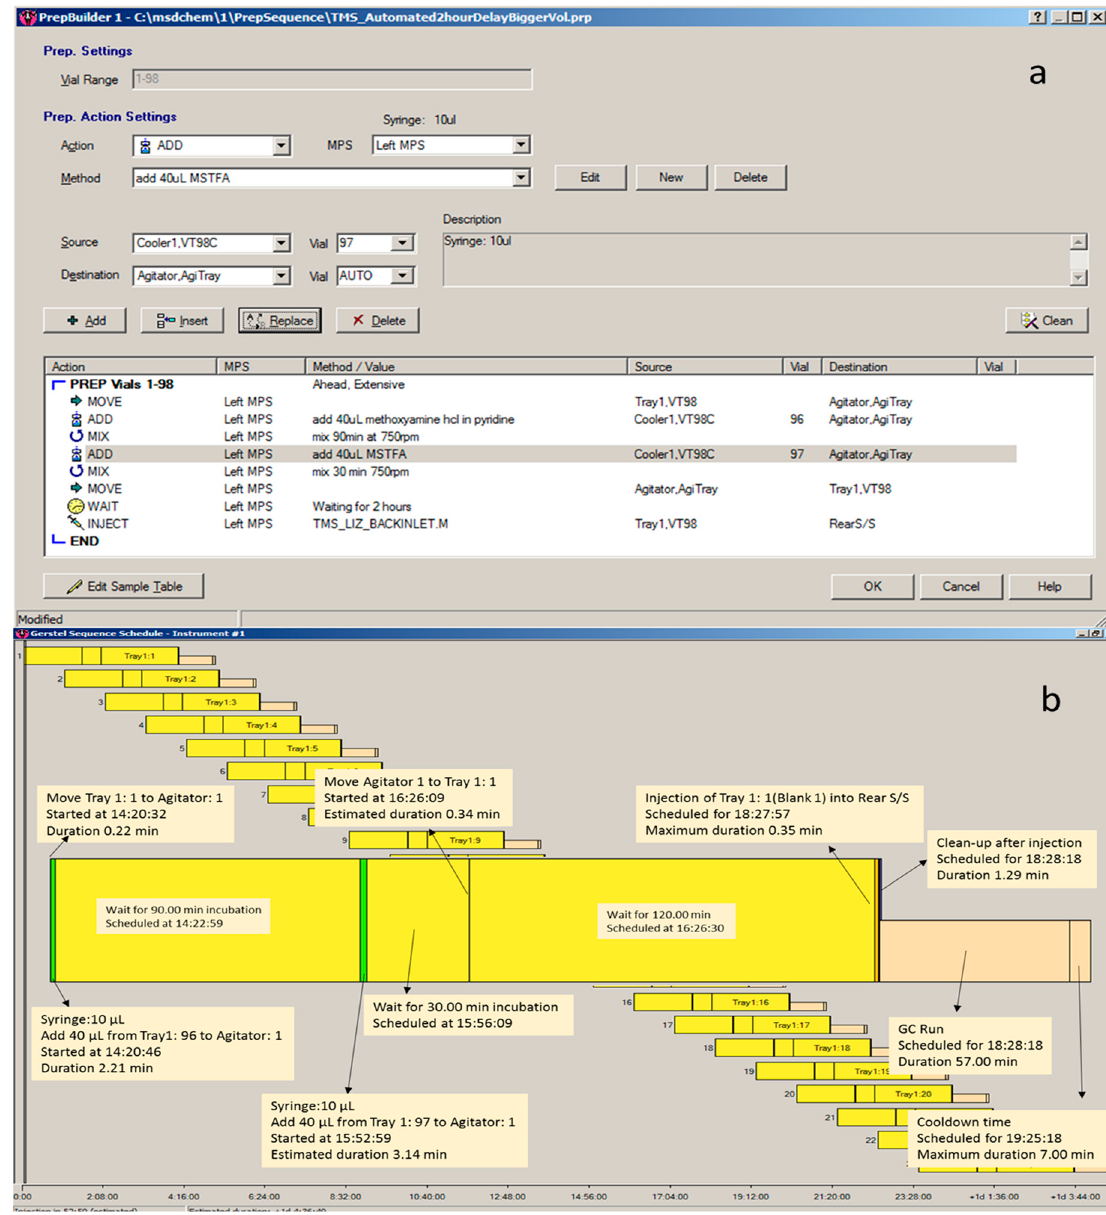
Figure 3. Screen shots from the Gerstel Maestro software showing the method for the sample preparation and injection step by step ( a ) and the overlapping the sequence ( b ).